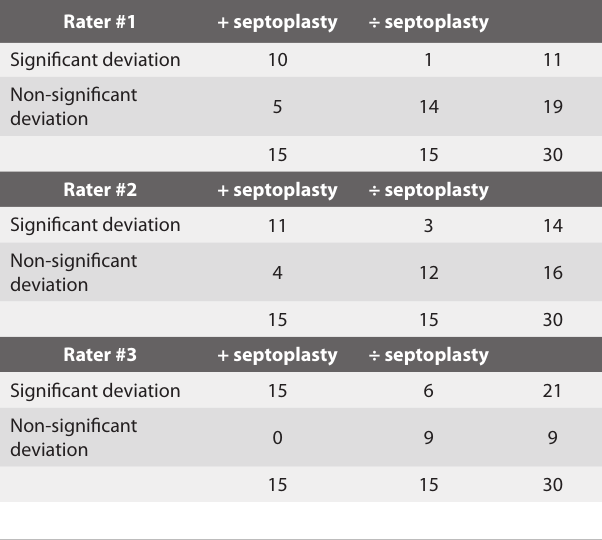
Table 2. Prediction of clinical significant deviations by all three